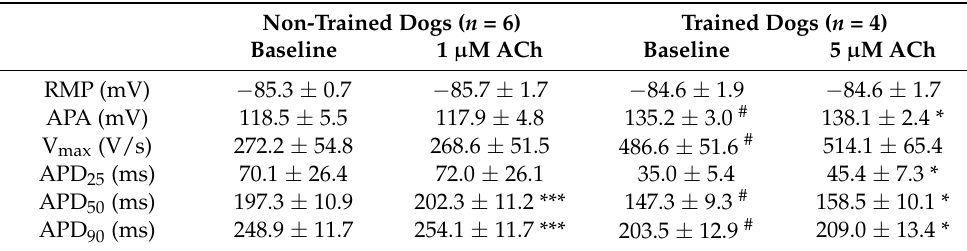
Figure 1. Typical action potential (AP) waveforms of canine Purkinje fibers (PFs) in absence (baseline) and presence of acetylcholine (ACh). ( a ) Effect of 5 min exposure to 1 µ M ACh on the AP of a PF of a non-trained dog at a basic cycle length (BCL) of 500 ms. ( b ) Effect of 5 min exposure to 5 µ M ACh on the AP of a PF of an exercise-trained dog. AP recordings of each panel originate from the same preparation and impalement. Average AP data from six non-trained and four exercise-trained dogs are listed in Table 2. Table 2. Effects of acetylcholine (ACh) on action potential characteristics of canine Purkinje fibers at a cycle length of 500